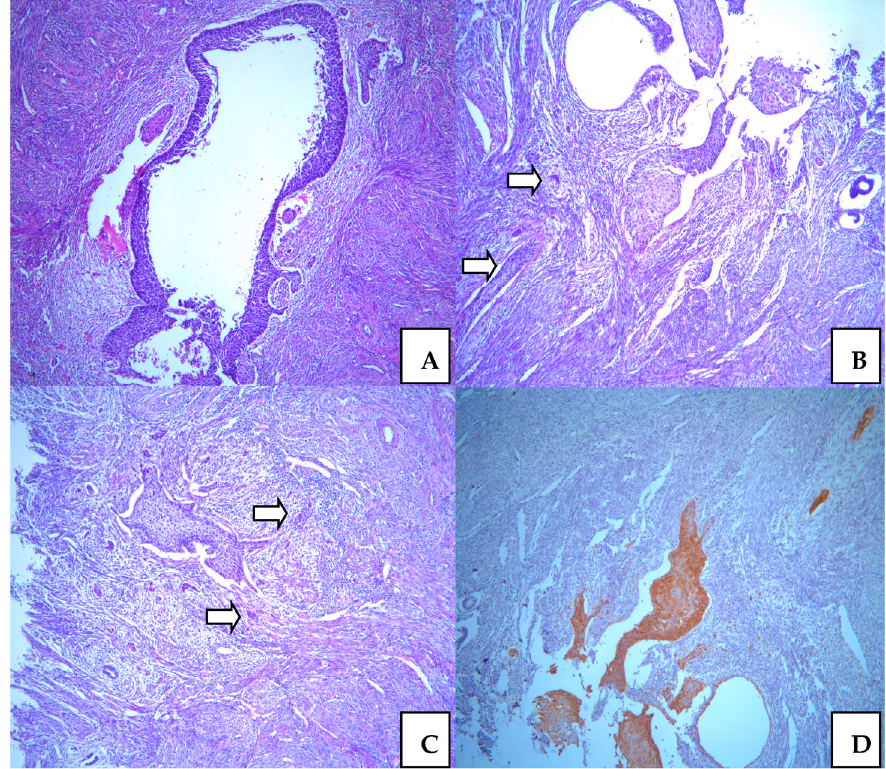
Figure 3. Squamocellular carcinoma in the uterine corpus with micoinvasive focus and surronding H-SIL colonization. Isthmic uterine part (( A ). × 50); Endometrium with microinvasive foci (arrow) (( B ). × 50, and (( C ). × 50); Immunostaining with p16 antibody confirm cervical origin of microinvasive focuses in endometrium (( D ). ×